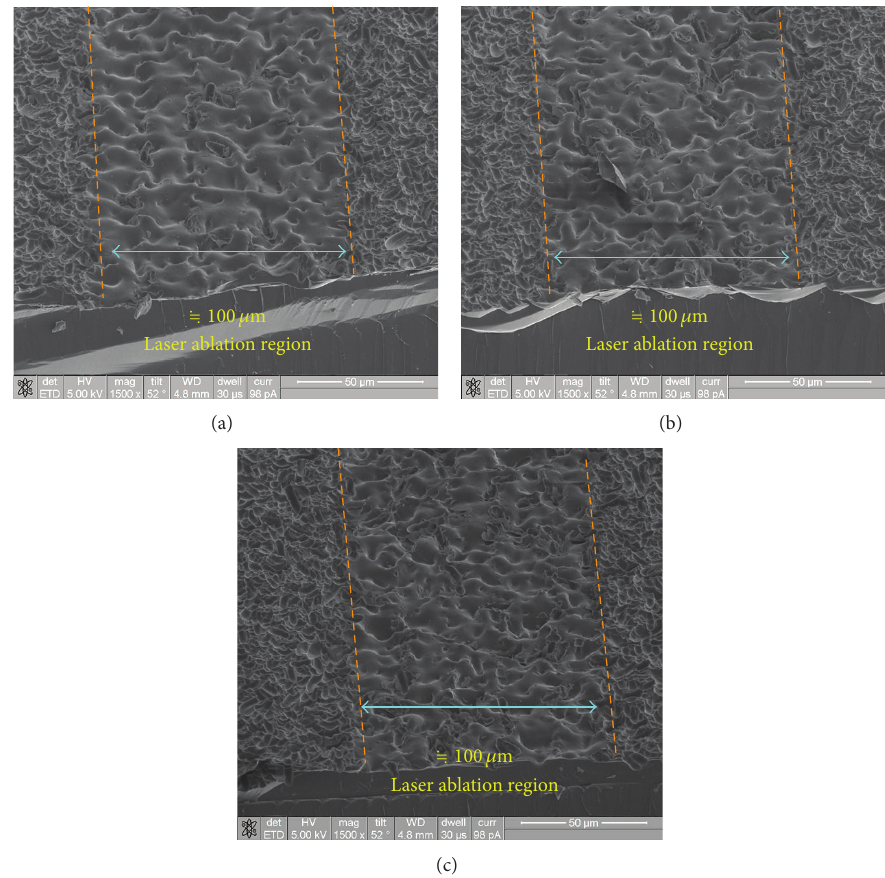
Figure 2: SEM images of mc-Si wafer after laser ablation process, with the fluences of (a) 5J/cm 2 , (b) 3.5 J/cm 2 , and (c) 2J/cm 2